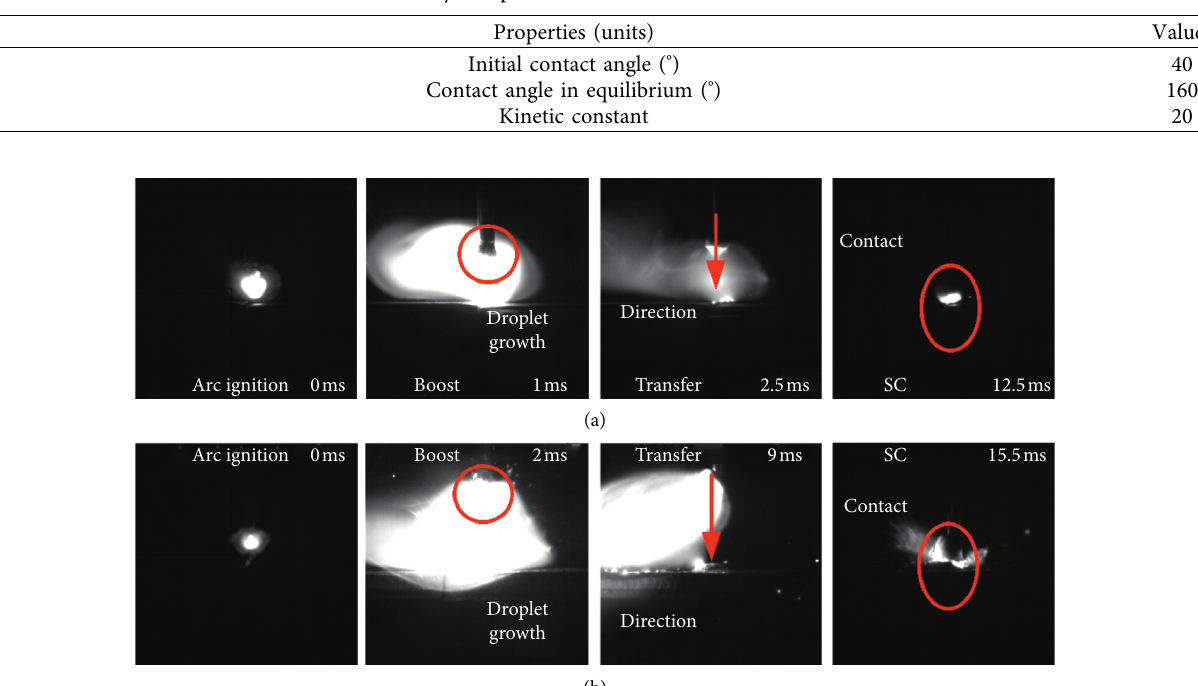
Figure 10: Metal droplet deformation. Table 3: Physical parameter values used for calculations.